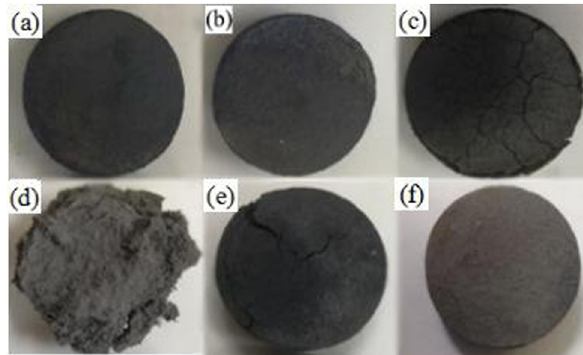
Figure 5: Images of briquette specimens with di ff erent basicity values reduced at 900°C for 1 h. ( a ) – ( f ) Briquette specimens #1 ( 0.2 ) , #2 ( 0.4 ) , #3 ( 0.6 ) , #4 ( 0.8 ) , #5 ( 1.0 ) , and #6 ( 1.2 ) .